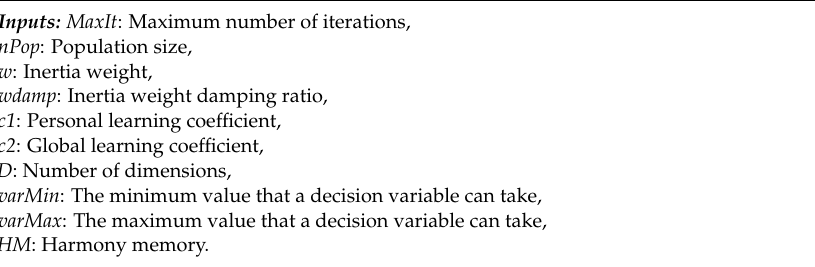
Algorithm 3 . Particle swarm optimization with IOBL